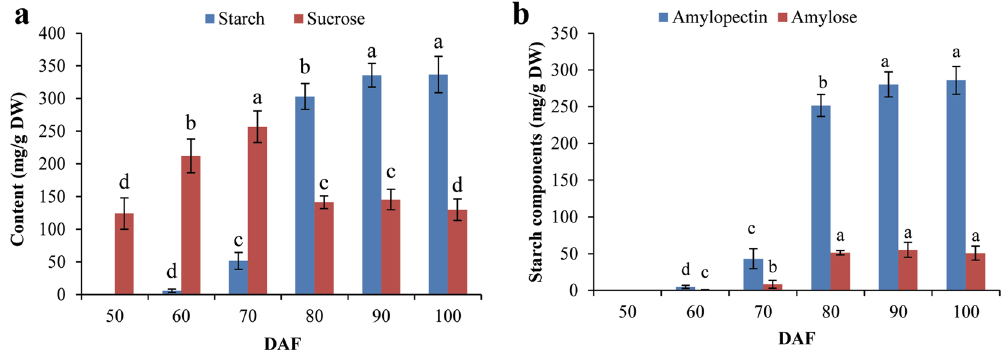
Figure 3. Sucrose and starch contents of CCSK at various developmental stages. ( a ) Sucrose and starch contents of CCSK at various developmental stages. ( b ) Amylose and amylopectin contents of CCSK at various developmental stages. Groups with distinct letters are significantly different at p < 0.05. Error bars display SD, n =